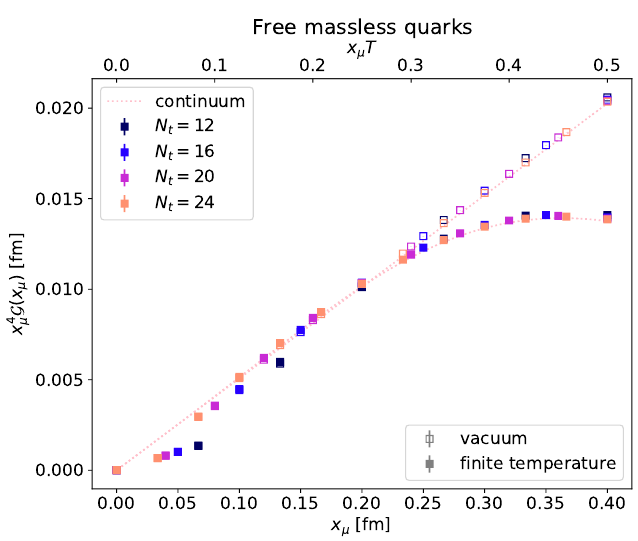
Figure 2 . Integrand of the fourth-moment observable x 4 N t = 12 , 16 , 20 , 24 (filled symbols) and their vacuum equivalents (open symbols). The dotted lines represent the continuum values of these